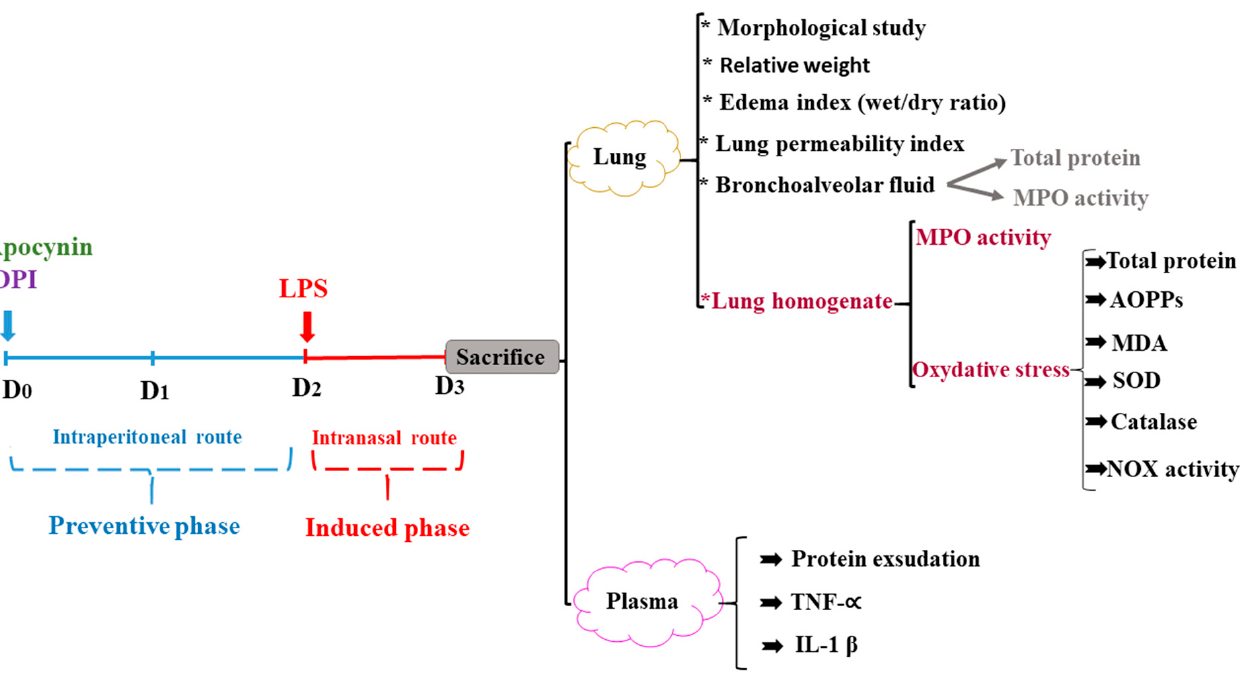
Figure 2. Schematic representation of the procedure for studying the effects of apocynin and DPI on acute lung inflammation induced by LPS.